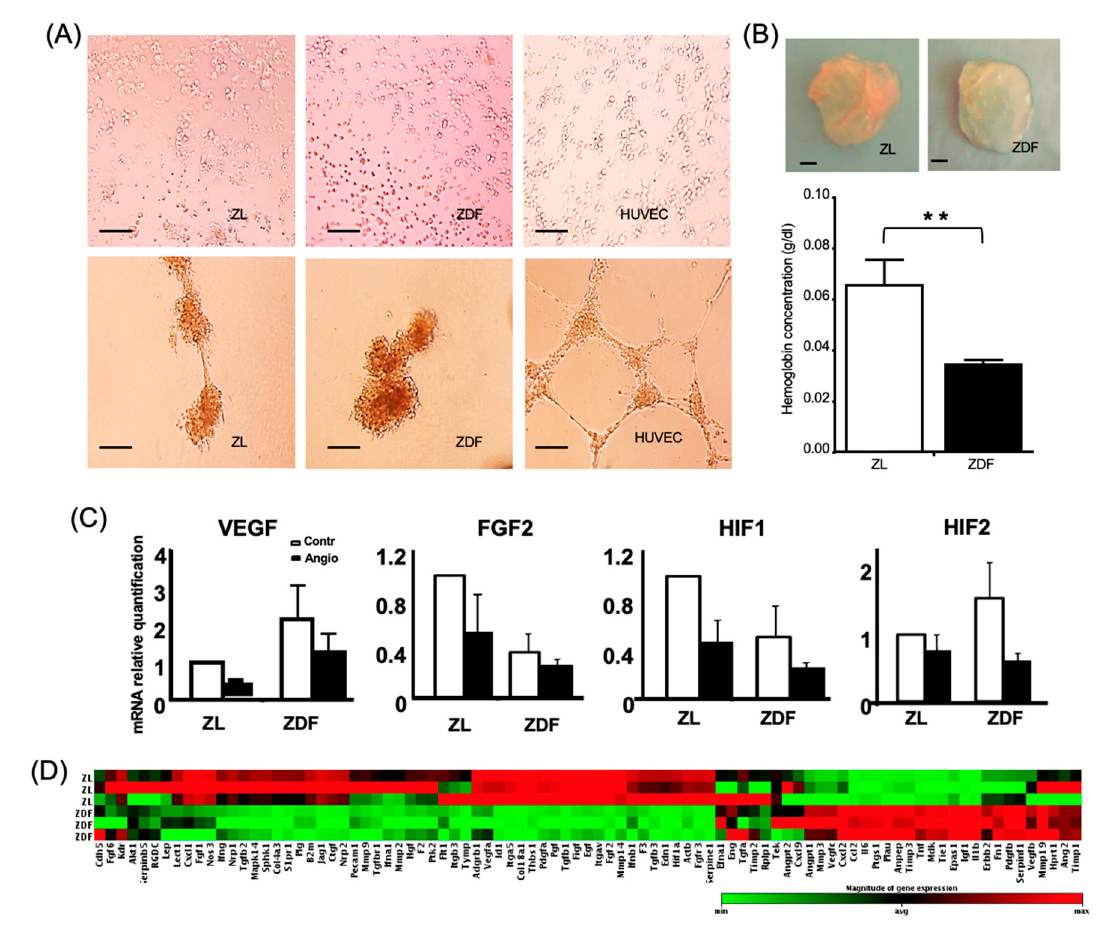
Figure 5. ZDF-BMMSCs are more angiogenesis inducing than their counterpart. ( A ) Light micrographs of ZL-, ZDF-BMMSCs, and HUVECs (Human Umbilical Vein Endothelial Cells) cultured in an angiogenic medium for a 14- day period and then on a Matrigel for 24 h, Scale bar = 100 μ m ( B ) Light micrograph of explanted Matrigel plugs seeded with ZL- and ZDF-BMMSCs (upper panel) and hemoglobin content of those plugs (lower panel) after 14 days implantation in nude mice, Scale bar = 1 mm ( C ) Expression of VEGF, FGF2, HIF1 , and HIF2 from ZL and ZDF-BMMSCs cultured with control (white) or angiogenic induction medium (black), ( D ) Expression of select angiogenic genes in ZDF-BMMSCs relative to the results obtained from ZL-BMMSCs under the same normoglycemic conditions of culture after 14 days, via quantitative PCR. Values are mean ± SEM. n = 3. ** P < 0.01. ZL-BMMSCs (i.e., from control rats). ZDF-BMMSCs (i.e., from diabetic rats).